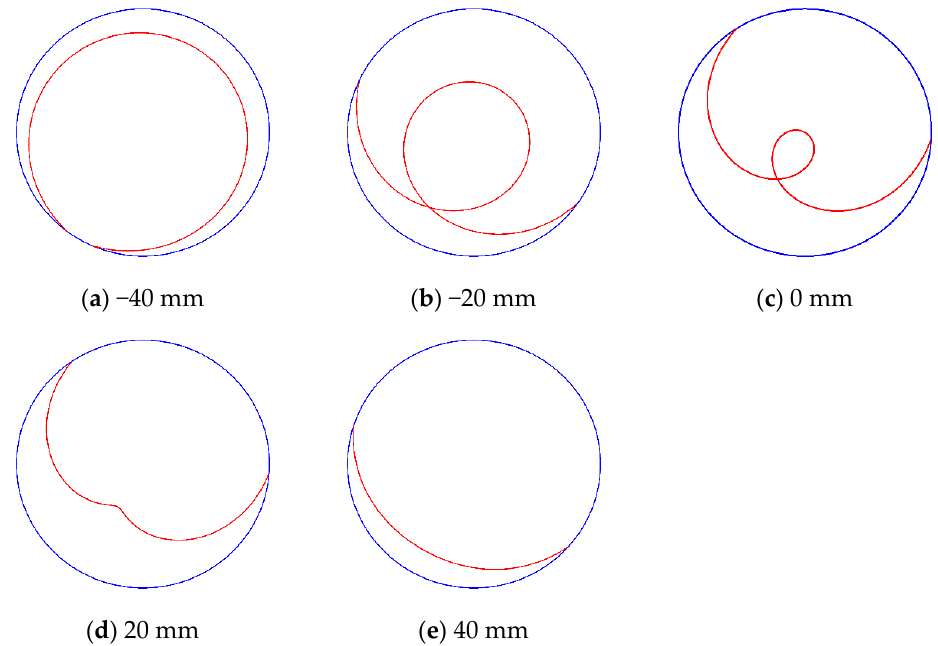
Figure 28. Motion trajectory of the agglomerated particles with different magnetic field eccentrici-